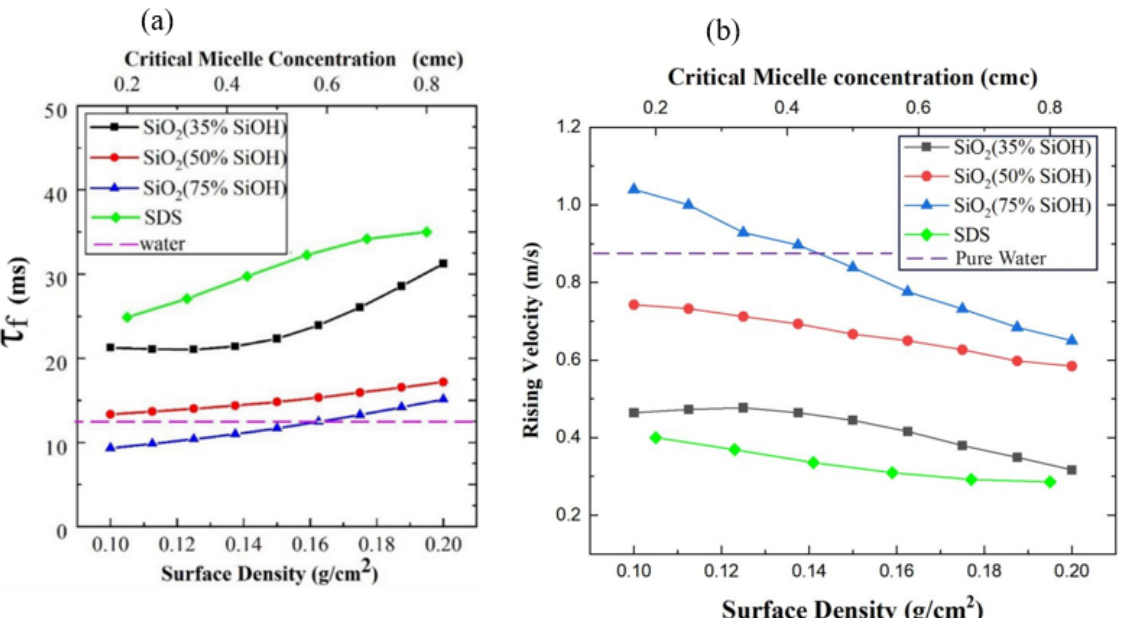
Figure 3. Time evolution of the bubble aspect ratio K during its rising, where a and b are diameters for the major and minor axes of the bubble.